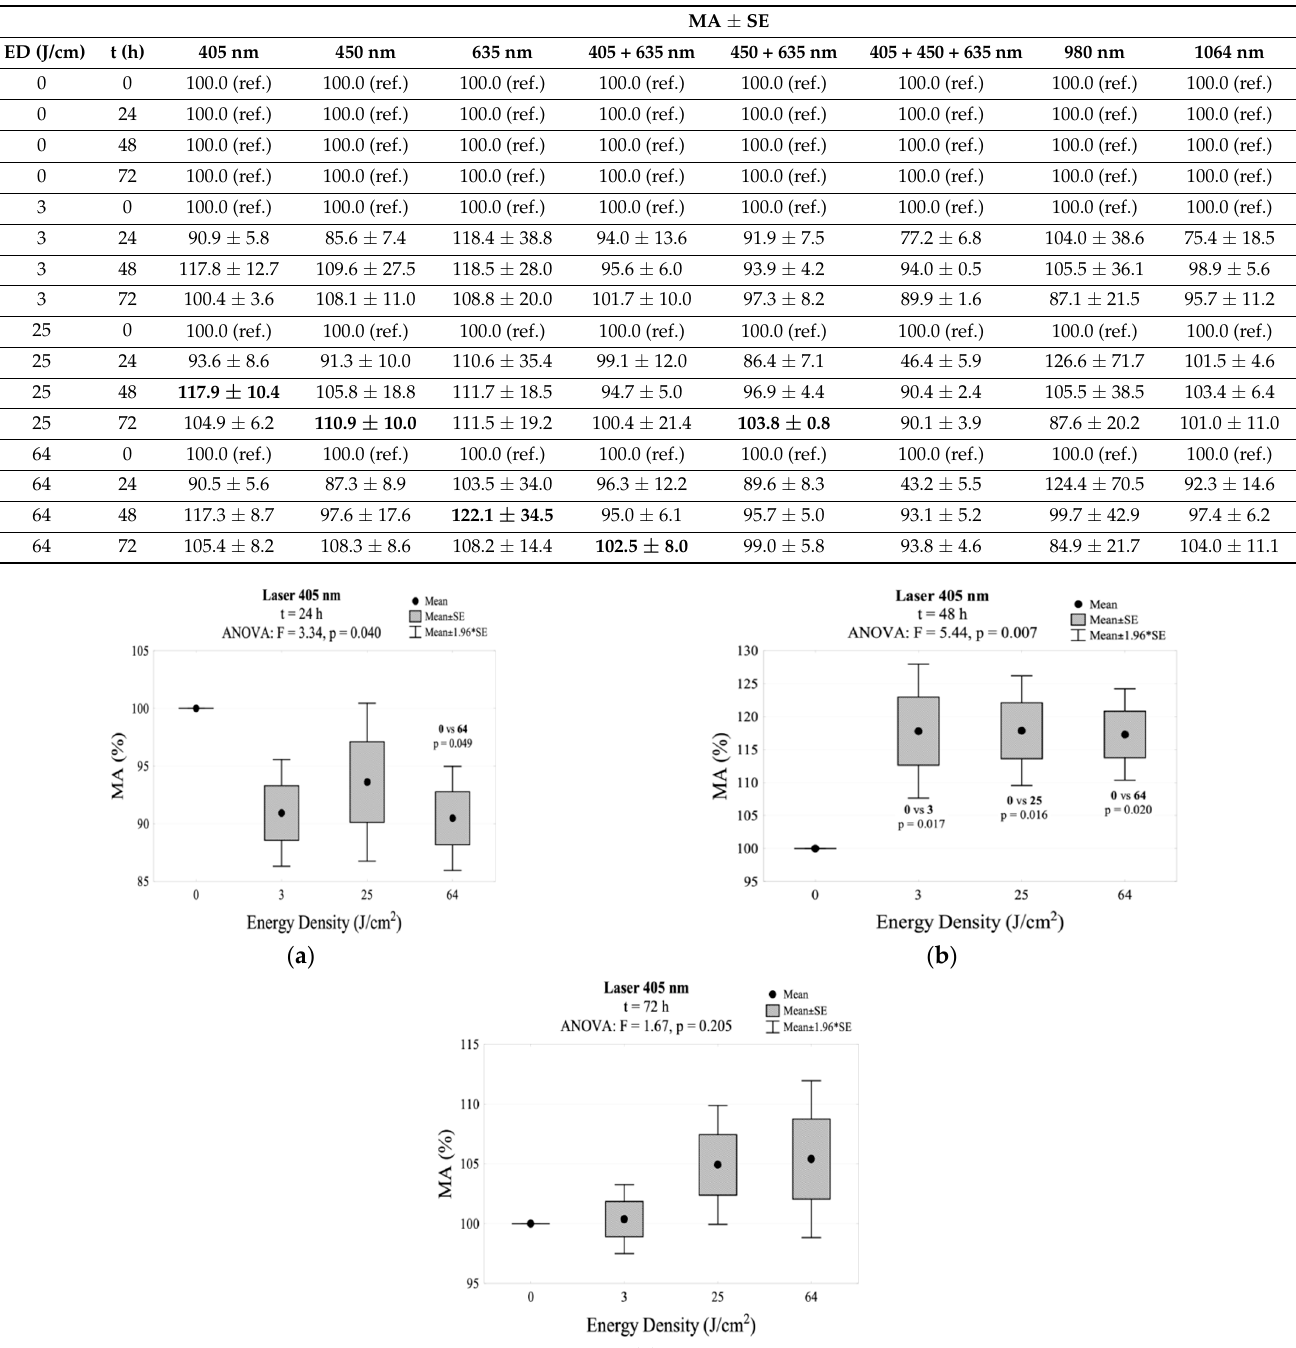
Table 2. Values of mitochondrial activity (MA) in function of wavelength, energy density (ED), and time (t) between irradiation and mitochondrial activity measurement (SE)—standard error, bold font- statistically significant difference versus control group, ref—control group).